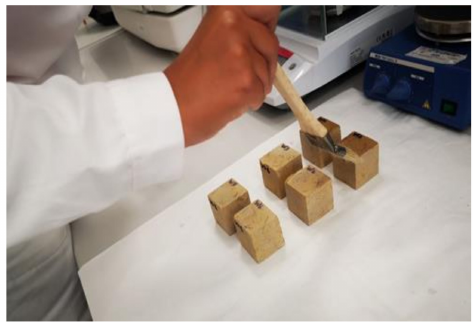
Figure 1. Application